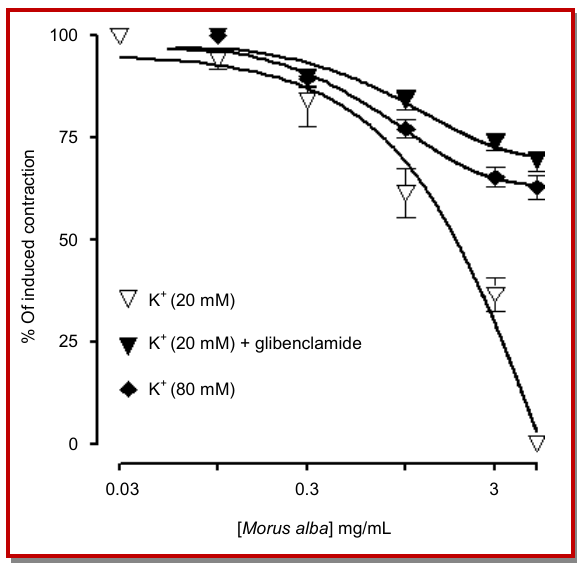
Figure 4: Concentration-response curves showing effect of the crude extract of Morus alba on low K+ (20 mM) in the absence and presence of glibenclamide (3 µM) and high K+ (80 mM)- induced contractions in isolated